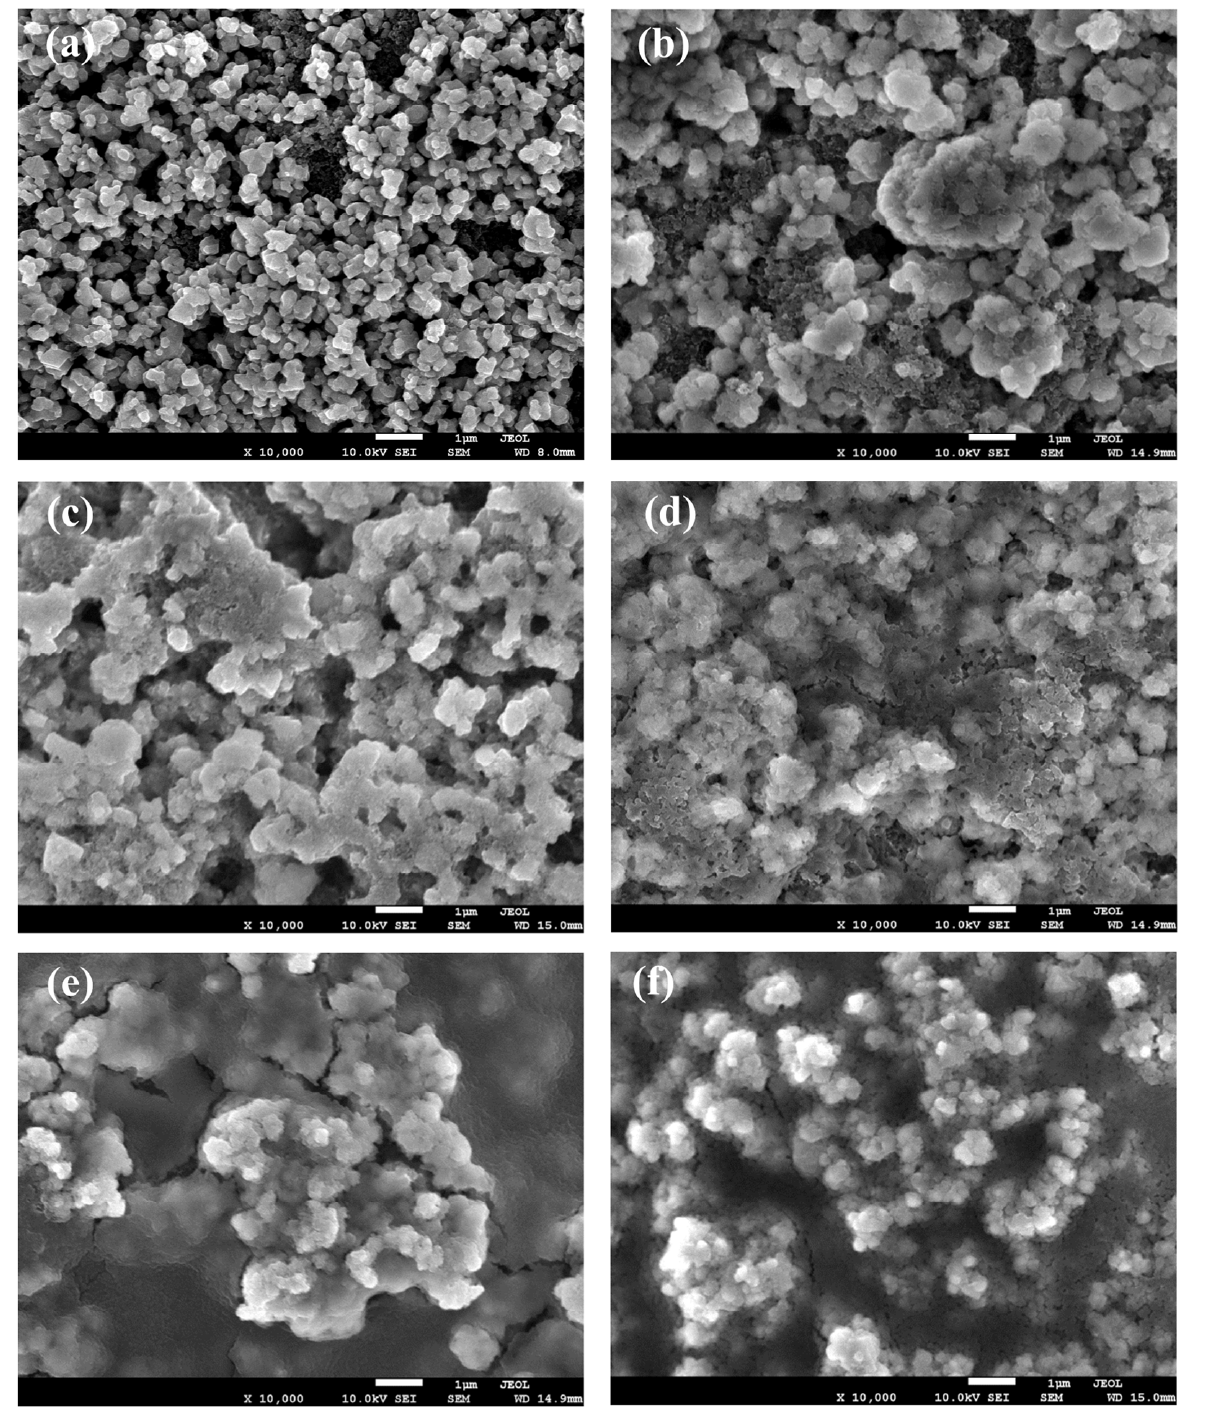
Figure 4. SEM images of LTO electrodes: ( a ) before cycle, ( b ) free additive, ( c ) 0.5, ( d ) 1.0, ( e ) 2.0, and ( f ) 4.0 wt.% BS at the 0.2 C-rate for 50 cycles.